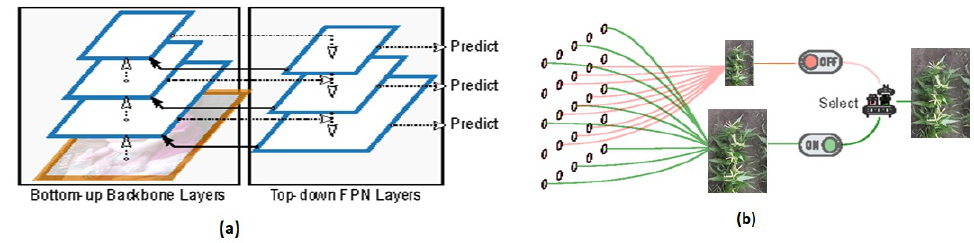
Figure 5. DetectoRS Schematic (ResNext-101); ( a ) RFP; ( b ) SAC.